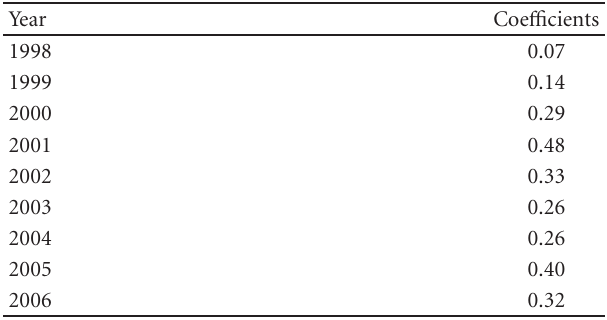
Table 1: Similarity Czekanowski coe ffi cients of grass and forbs species between the disturbed and undisturbed